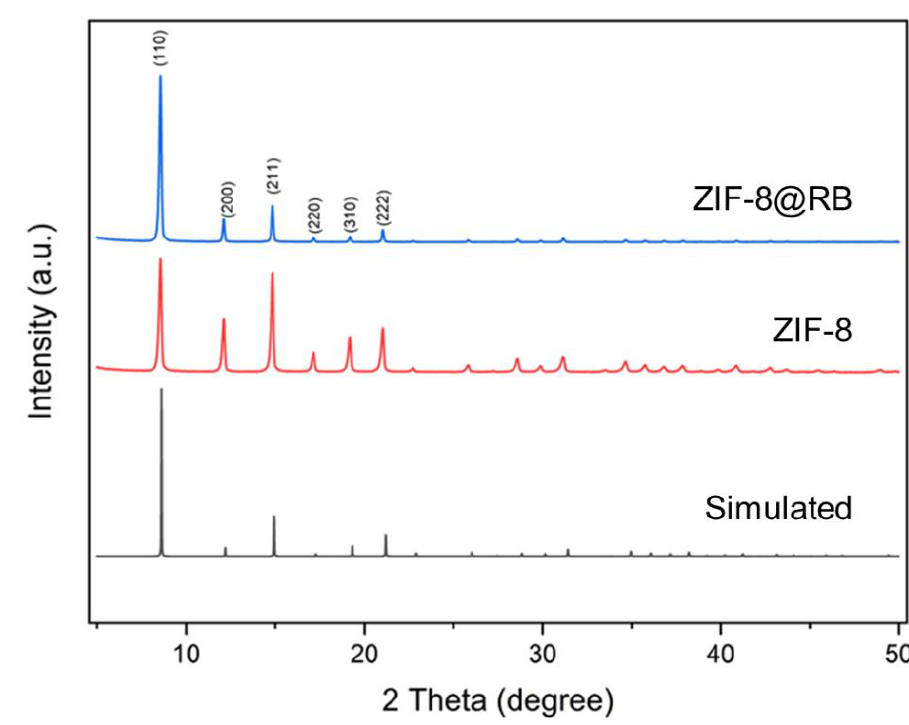
Figure 3. XRD patterns of ZIF-8, ZIF-8@RB and simulated ZIF-8.